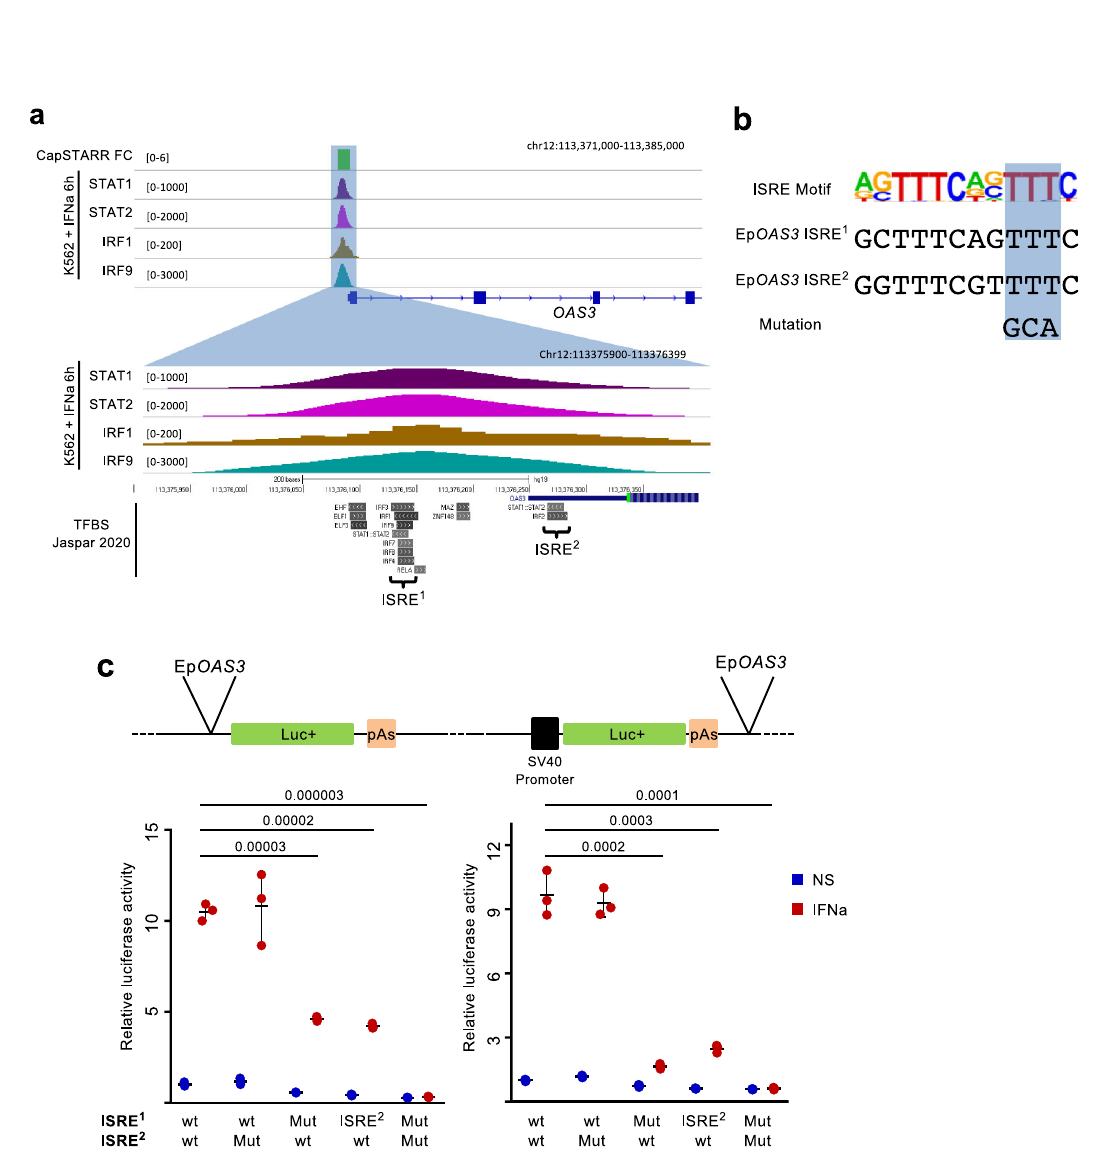
Fig. 5 Luciferase assay of promoter and enhancer activity in wild-type and OAS3 promoter mutants. a Genome browser tracks showing the fold-change of CapSTARR-seq activity and the ChIP-seq signal of the indicated TFs surrounding the OAS3 Epromoter. The lower panel shows the location of signi fi cant TF-binding sites (Jaspar 2020) and the relative position of the two Interferon-Stimulated Response Element (ISRE) motifs in comparison with the ChIP-seq peaks. b Consensus sequence of the ISRE motif, as well as, the genomic sequence of the two identi fi ed ISREs in Ep OAS3 , and the mutation made for the luciferase test is highlighted. c Luciferase assays to quantify the promoter (left) and the enhancer (right) activity of the wild-type (wt) OAS3 Epromoter or with the indicated mutations (Mut) in non-stimulated (blue) or IFNa-stimulated (red) in K562 cells. Central values represent the median of the signal and the error bars represent the s.d. of three independent replicates. P -values were calculated by two-sided Student ’ s t